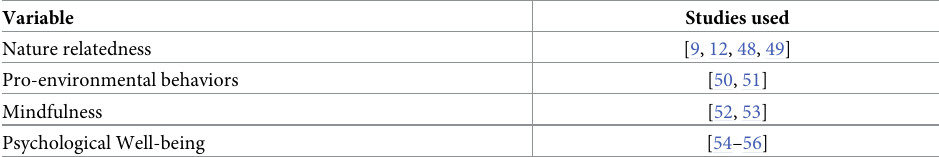
Table 1. Studies used to design indicators related to research